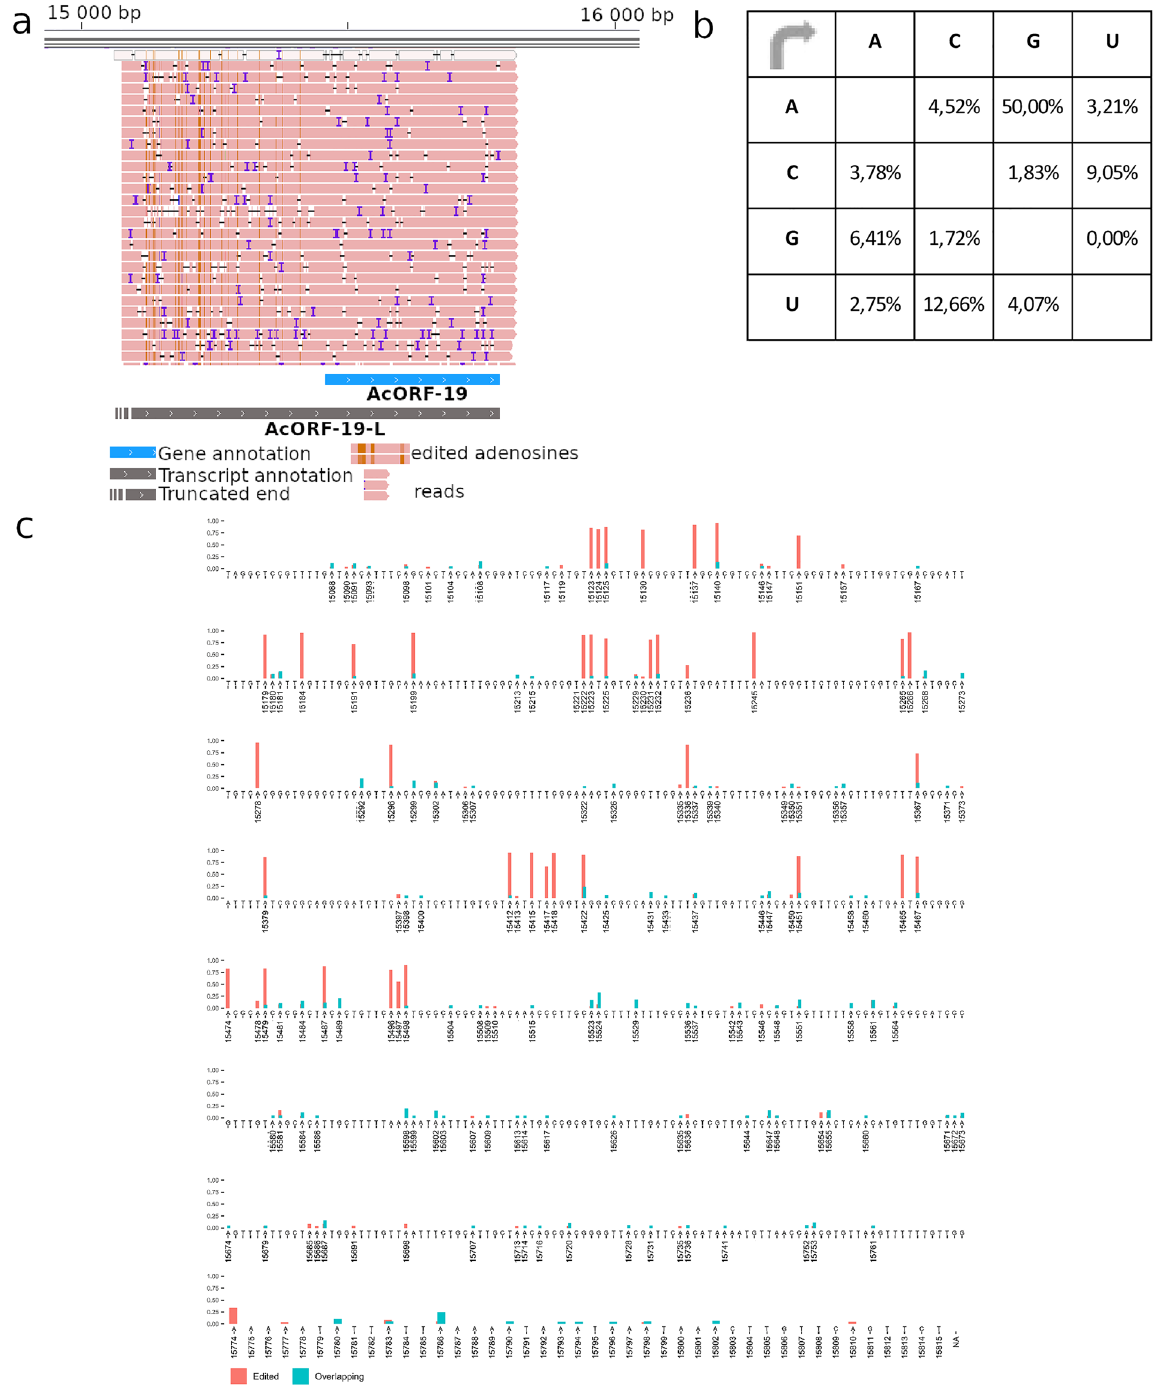
Figure 5. Hyper-editing of AcORF-19 transcript. ( a ) A- > I hyper-edited AcORF-19 reads. The image shows the AcORF19-L transcript reads in pink. The brown lines on the reads indicate base modifications. These modifications are located in the 5 ′ -UTR of the canonical transcript. The reads were visualized with IGV 2.11.3 software 55 . ( b ) Substitution matrix of AcORF-19 reads. Reference nucleotides are found on the left side of the substitution matrix, while the right side of the matrix contains the percentage of nucleotides. It can be seen that that more than 50% of them are G letter. The substitution matrix was created with Microsoft Excel 2021 software 48 . ( c ) The sites and frequency of A- > G substitution on AcORF-19 transcript (indicated on the genomic region encoding this transcript). High-frequency substitutions indicate A- > G editing events, whereas low- frequency substitutions indicate sequencing errors. Red color indicates the high, whereas blue color shows the low frequency of editing. The plot was made with the ggplot2 r package 53